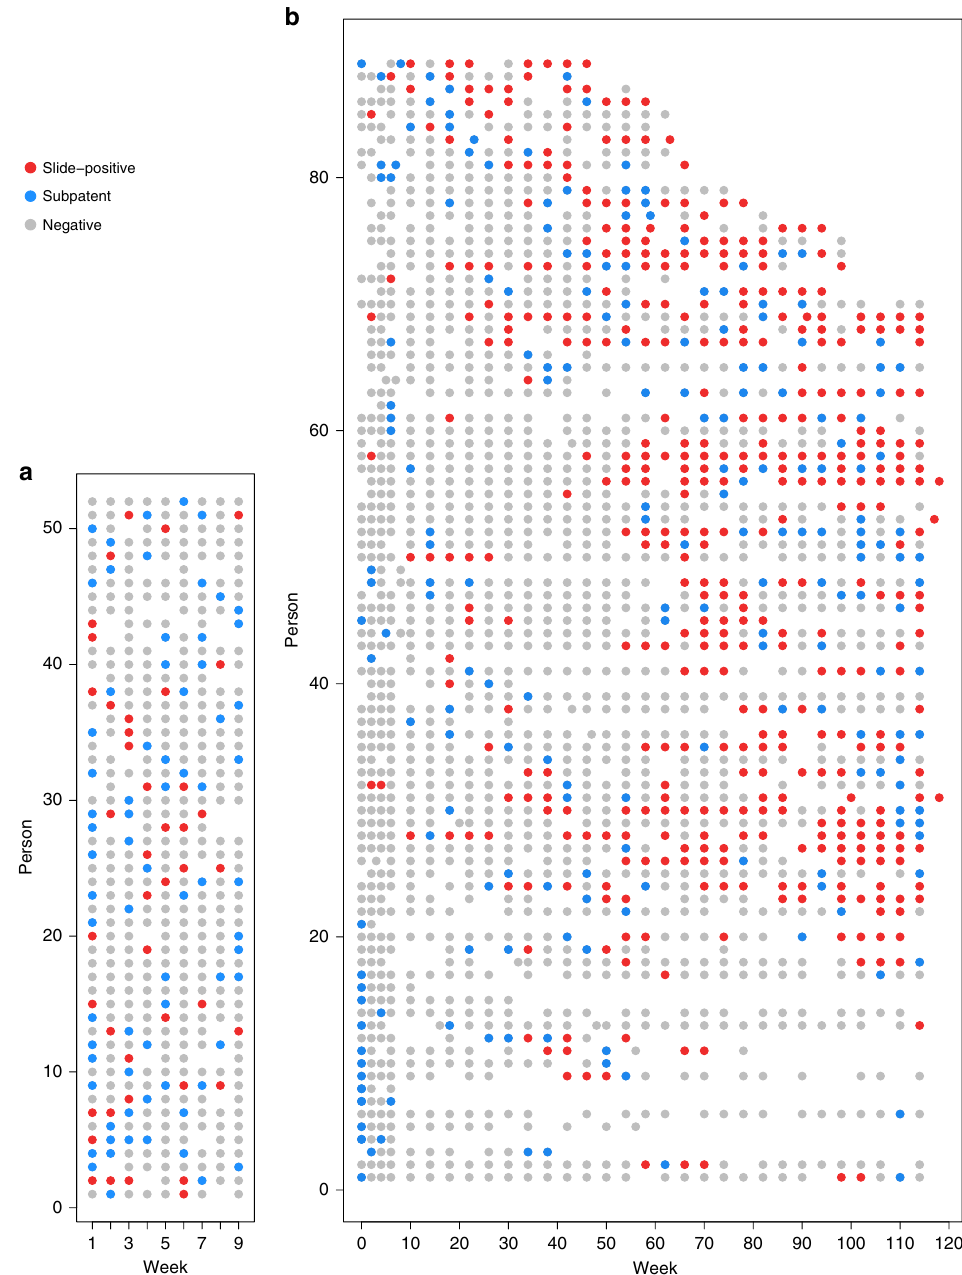
Fig. 4 Example longitudinal data in a subset of individuals who experienced submicroscopic parasitaemia. The data include information by microscopy (slide-positive) and PCR in ( a ) all-age individuals in Senegal in 2005 62 and ( b ) a birth cohort in Ghana 64 . Each row represents a single individual, with time on the x- axis (time = age in the Ghana cohort). Individuals were sampled weekly in Senegal and every 2 – 4 weeks in Ghana, and the colours indicate their infection status at each sampling time. Blank space indicates missing data. Source data are provided as a Source Data fi